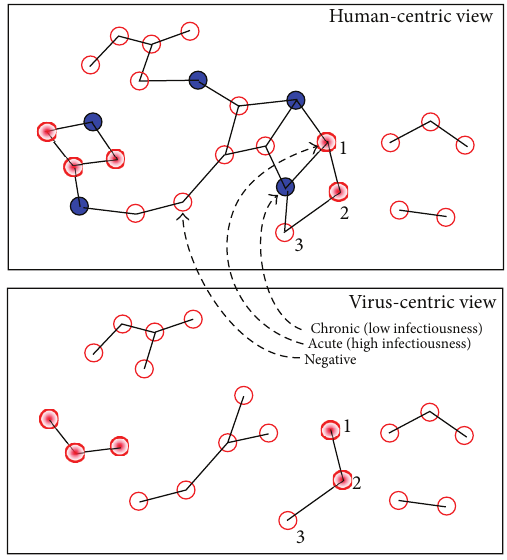
Figure 3: (Top) Risk network with 10 HIV+ (4 acute) out of 26 nodes; (bottom) virus-centric view, FW: 15/16 = 0.9375